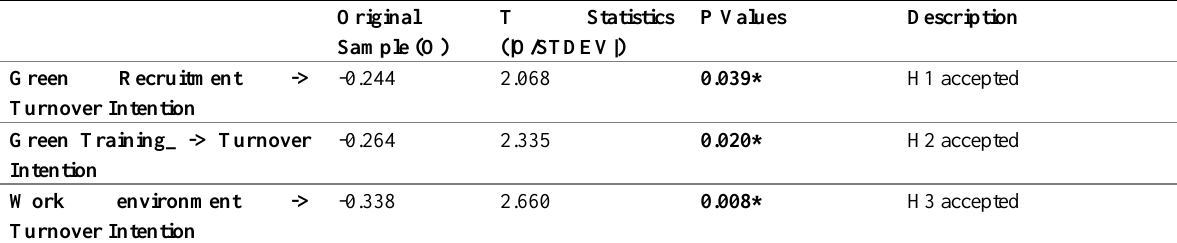
Table 6: Testing Results of Relationships Between Constructs (Direct